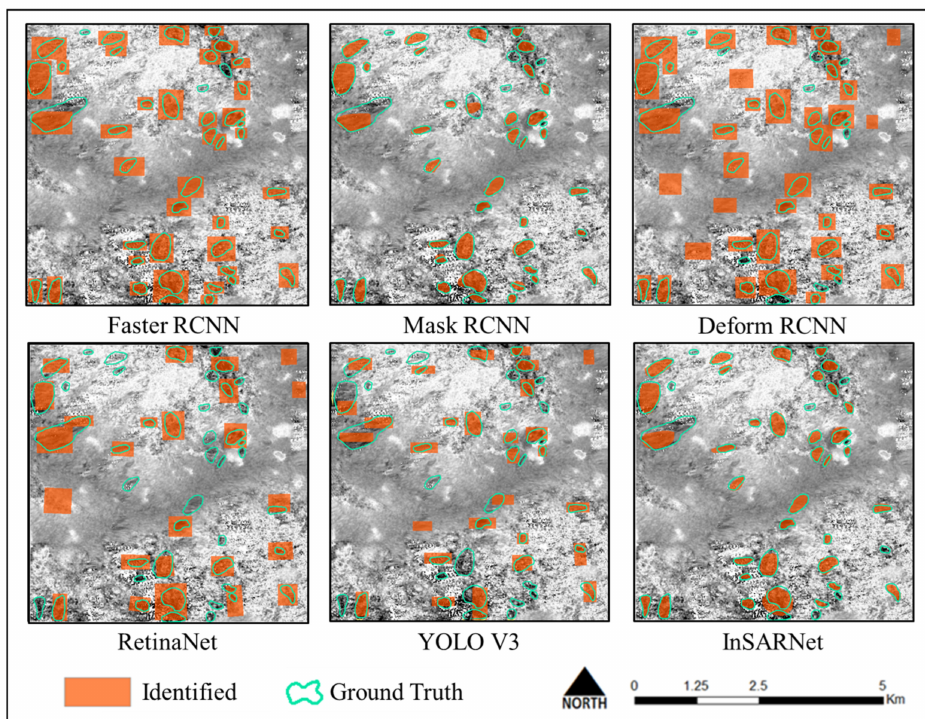
Figure 23. Comparison of different models in test area